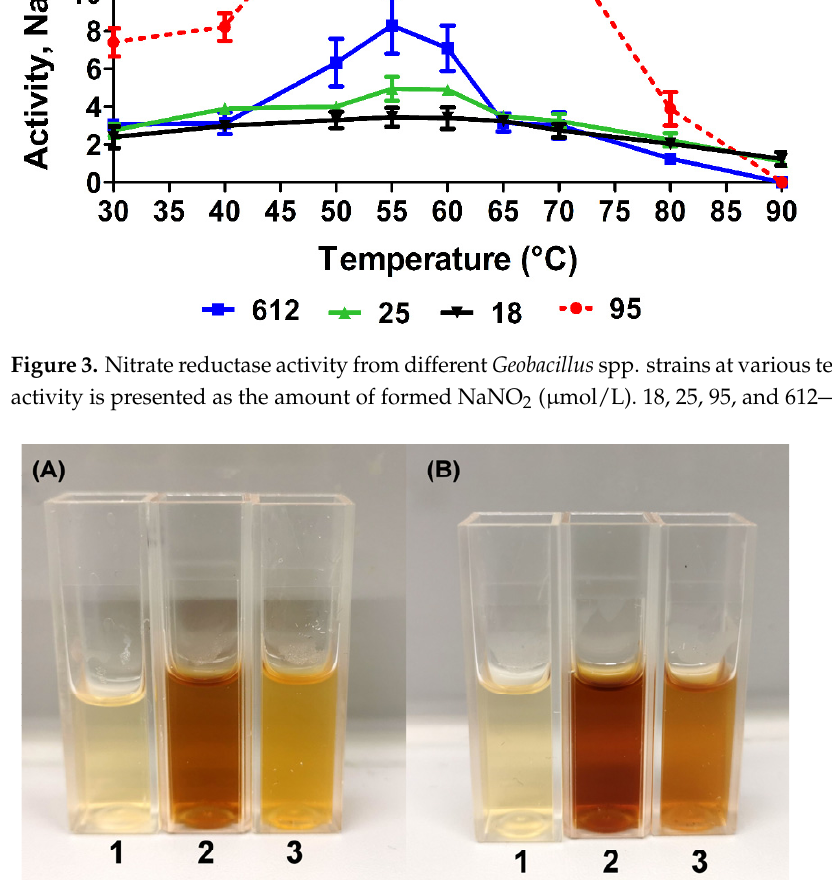
Figure 3. Nitrate reductase activity from different Geobacillus spp. strains at various temperatures.